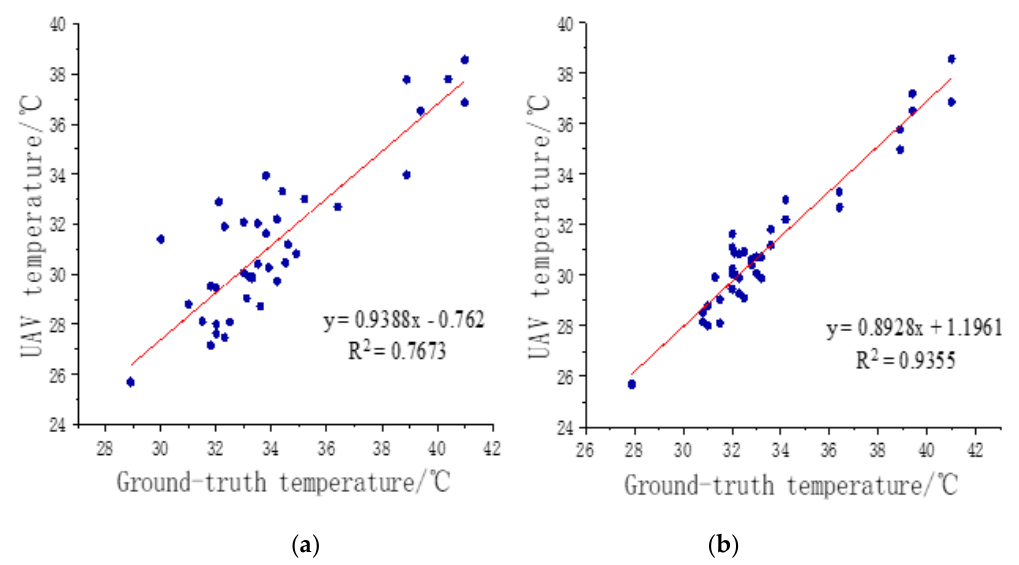
Figure 6. Comparison of the prediction accuracy of canopy temperature values with, ( a ) linear fitting results of the canopy temperature value from raw infrared thermal images and, ( b ) linear fitting results of the canopy temperature value from the infrared thermal images by Canny.